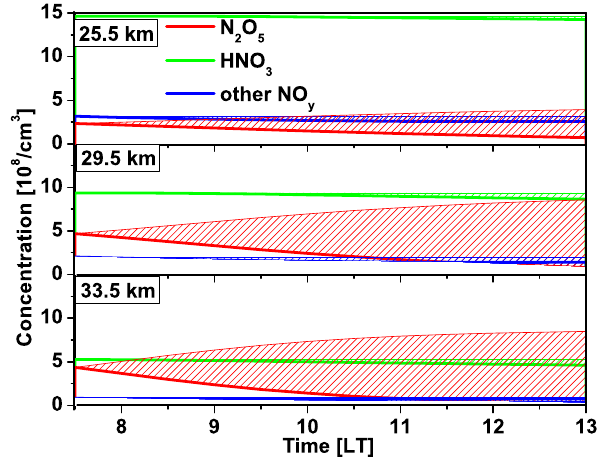
Fig. 1. Temporal evolution of N 2 O 5 (red), HNO 3 (green) and the sum of other NO y species ( ClONO 2 + HO 2 NO 2 + BrONO 2 , blue) for different altitudes of the tropical mid-stratosphere (5.1 ◦ S, 43.6 ◦ W). The lower boundary of the striped area denotes the temporal evolution of the particular gas, and the striped area shows the total amount of NO x , which is released by photolysis from the considered NO y species. Note that the release from N 2 O 5 is double due to two N atoms.